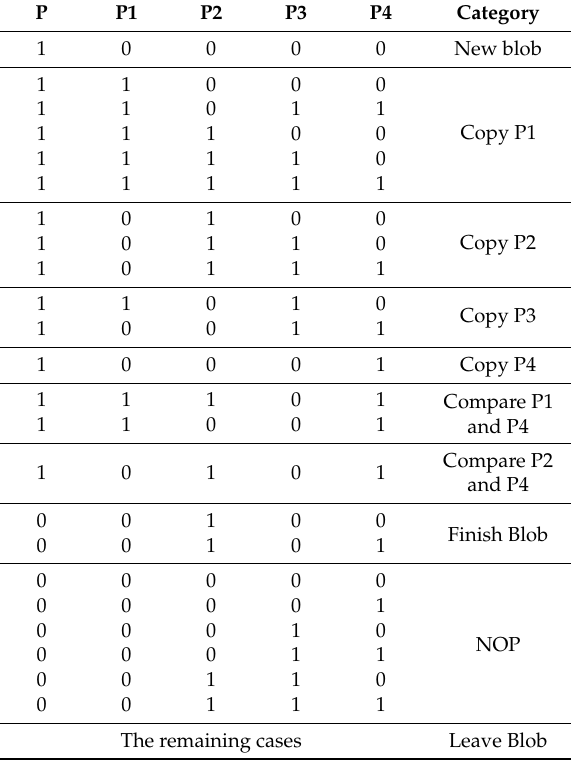
Table 1. Categories based on the input